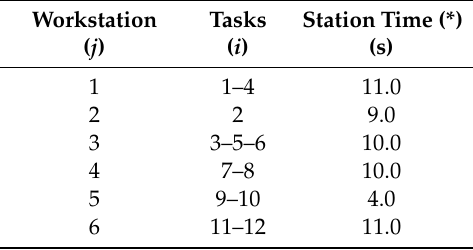
Table 4. Tasks assigned to workstations.